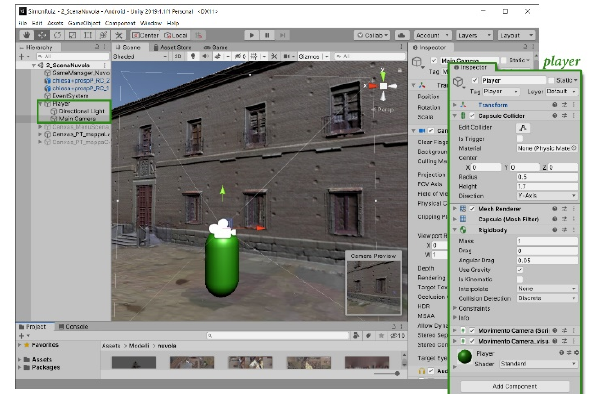
Figure 13: Construction of the player and display of the different components that characterize